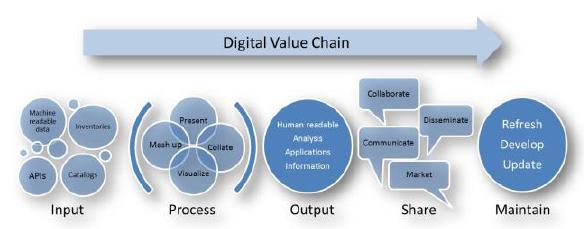
Figure 1. Digital Value Chain (Cobb, 2013)